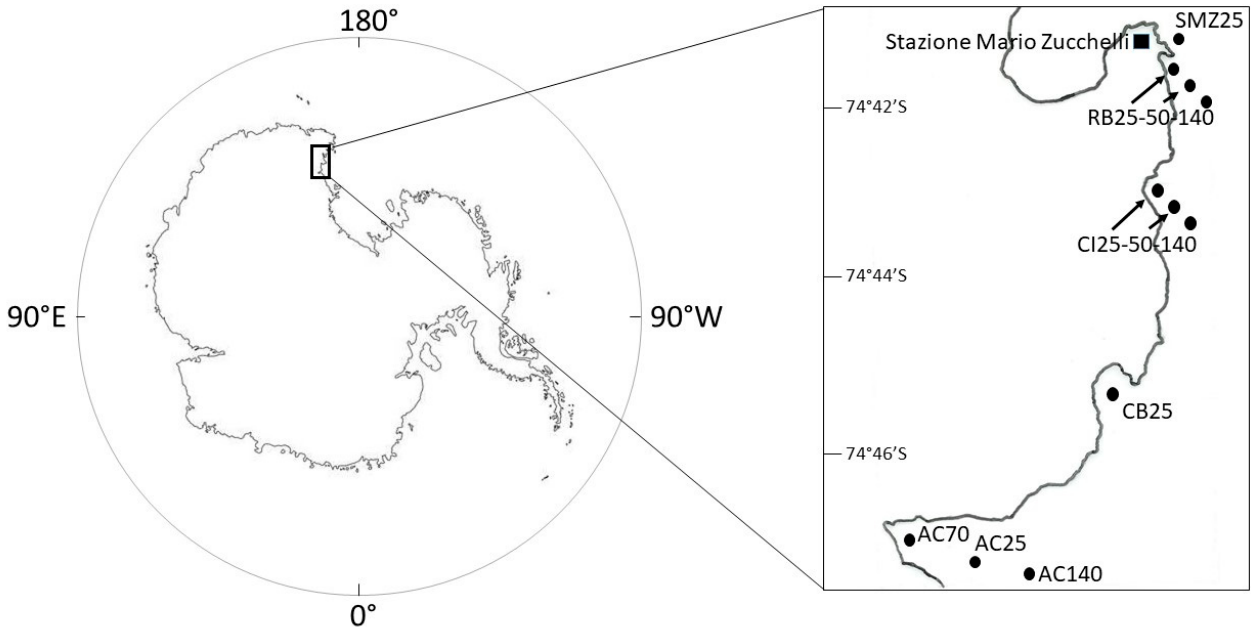
Figure 1. Map of the studied area and sampling stations.